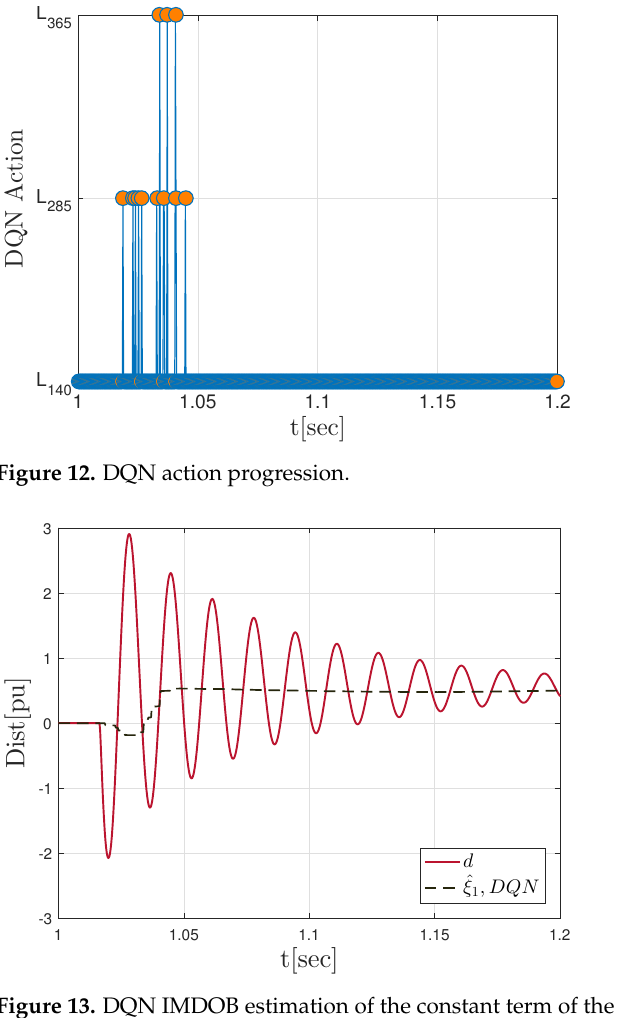
Figure 13. DQN IMDOB estimation of the constant term of the disturbance using ADC